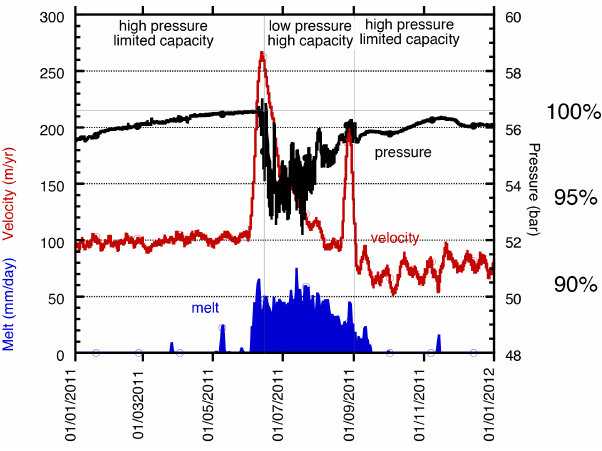
Figure 5. Seasonal cycle of water pressure, melt and velocity at SHR starting in January 2011. Note how the onset of significant melt leads to high magnitude acceleration and a short period of wa- ter pressure in excess of the overburden pressure (horizontal grey line), which implies floatation. Later, the ablation season variability in the water pressure remains visible but the amplitude is dimin- ished. During the ablation season the hydraulic system of channels develops (phase 1 in the figure) and closes once the melt decreases (phase 3). Note that even in autumn and early winter, single melt events affect water pressure and ice velocity. Ablation rates are lin- early from 0 to 8.5cm w.e. per day. The percentages indicate the pressure scaled by the overburden